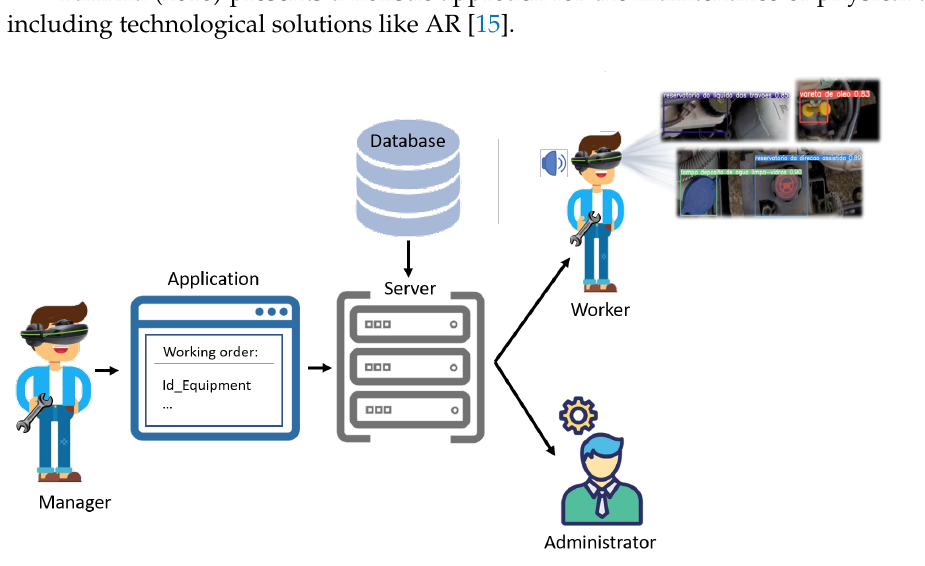
Figure 2. System architecture, showing the main components and interactions. The technician wears Augmented Reality glasses, where he receives directions to go through the procedures of the Working Order, that is created and managed through a CMMS